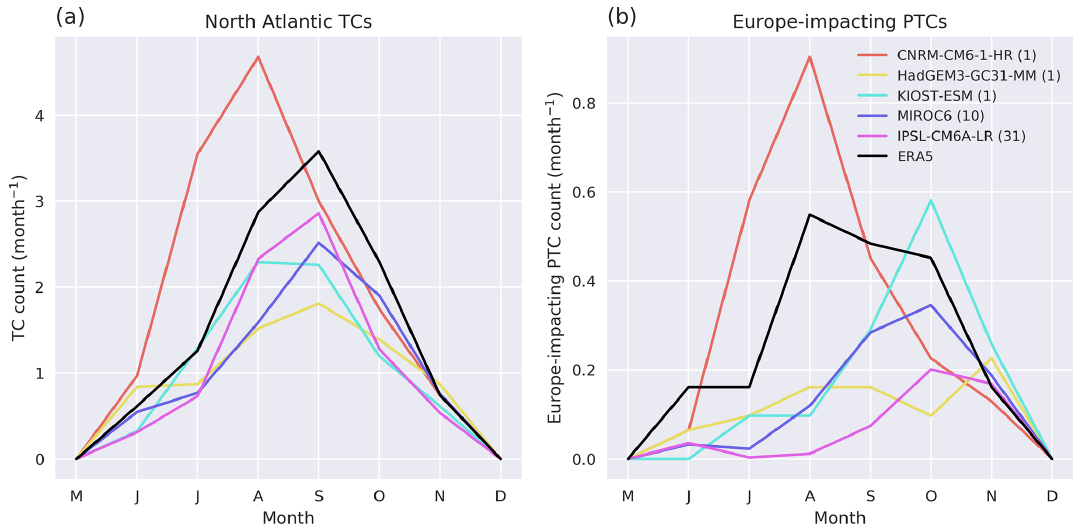
Figure 3. Seasonal cycle of North Atlantic TCs (a) and Europe-impacting PTCs (b) in the historical run (1984–2014) of five CMIP6 models (coloured lines) and ERA5 (same time period, black). Cyclones are binned by the month of genesis. TCs forming outside of hurricane season are not included in this study, and so these months are set equal to zero. The number of ensemble members used for each model is shown in brackets in the key. Table 2. Counts of Europe-impacting PTCs, North Atlantic TCs, likelihood of recurvature, and likelihood that a recurving TC will reach Europe for the historical (1984–2014) period and the future (2069–2099) period under the SSP5-85 scenario. Fractional changes are shown under the “Diff” columns. Bold values represent significance at the 95% level using a bootstrapping method. N TC F Rec F Europe | Rec N Europe Hist SSP Diff Hist SSP Diff Hist SSP Diff Hist SSP